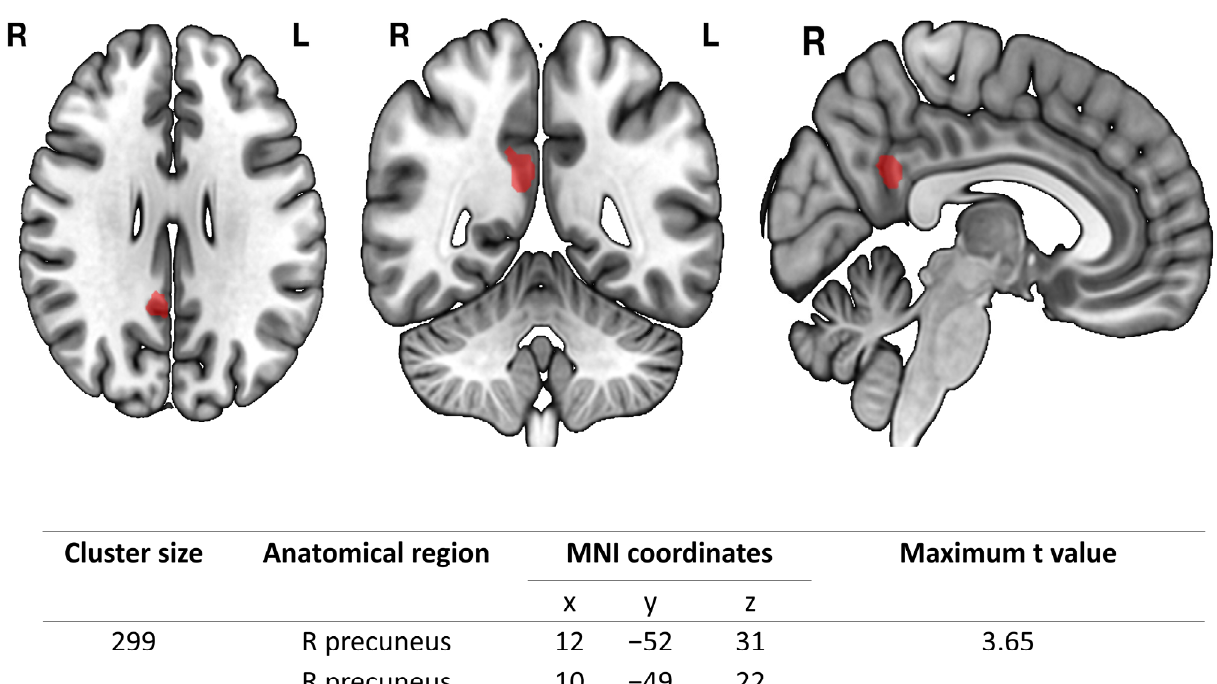
Figure 1. The boxplot shows the plasma levels of AD biomarkers. The OSA group had significantly higher levels of plasma T-tau and A β 42. The A β 40 level showed no significant difference between the two groups. * p < 0.05.